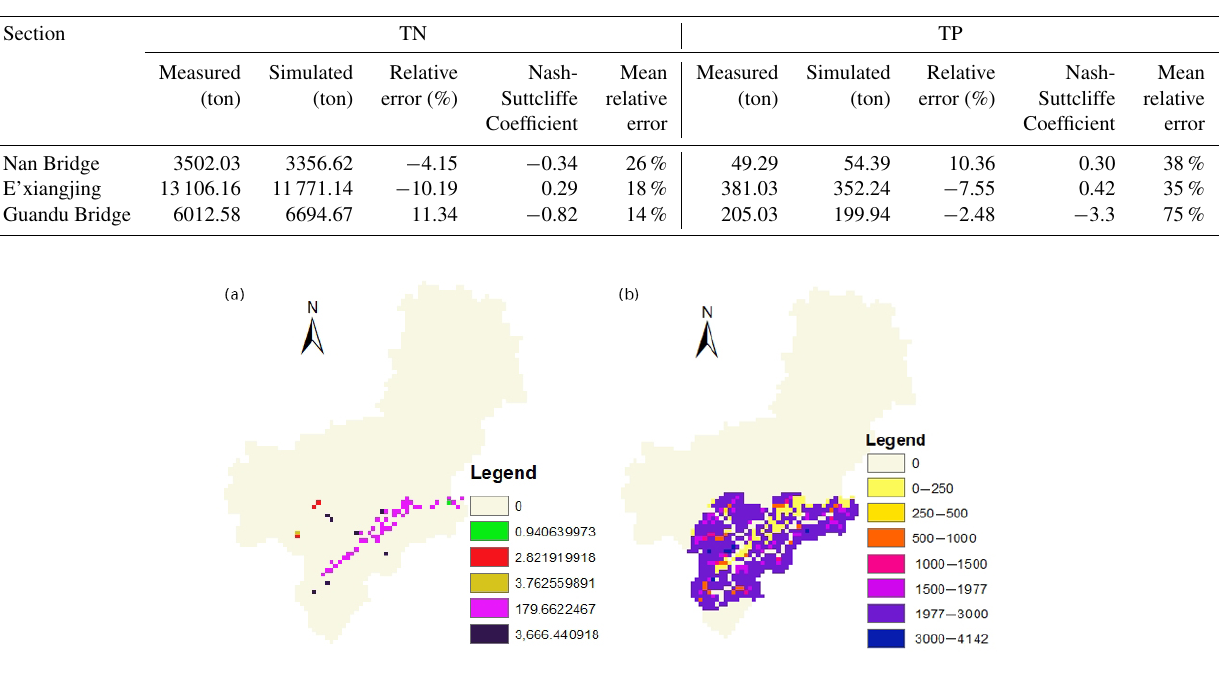
Figure 5. The spatial distribution of TN on 1 July ( a , wet season) and 1 February ( b , dry season), kg.